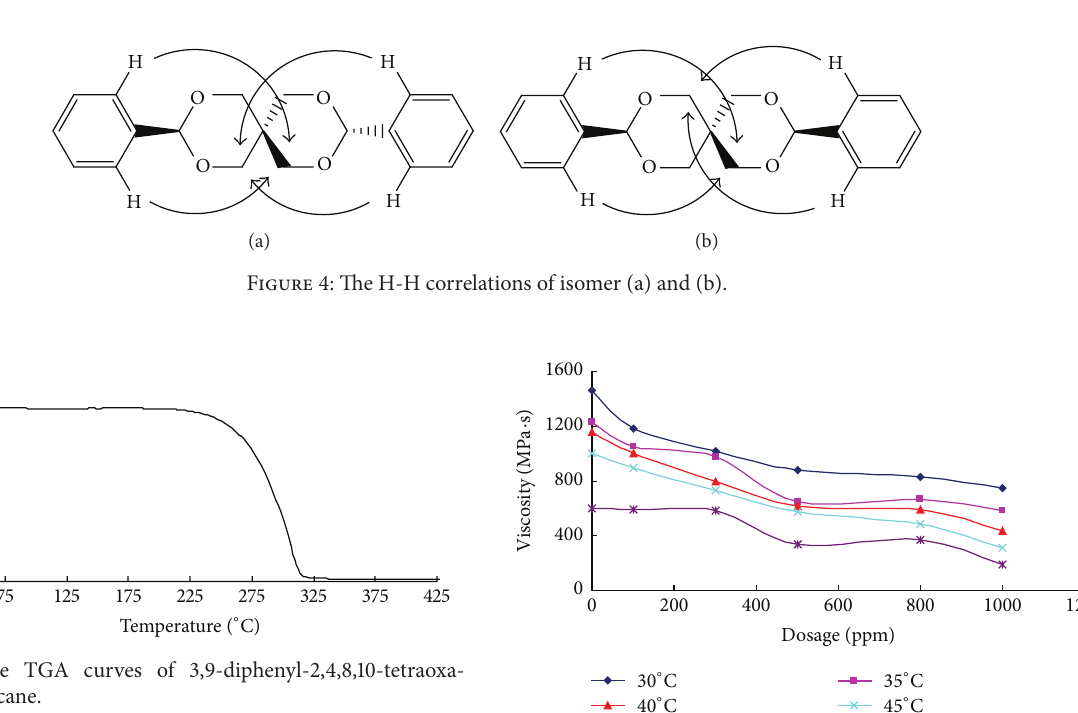
Figure 3: The isomers of 3,9-diphenyl-2,4,8,10-tetraoxa-spiro[5.5]undecane.